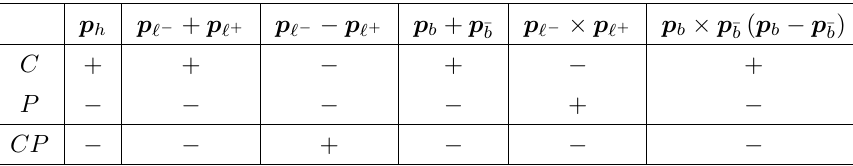
Table 1 . Momenta with well-de(cid:12)ned C and P eigenvalues. The b; (cid:22) b; ‘ + and ‘ (cid:0) are the top decay products. The last column is a rank-2 tensor | a direct product of an axial and a polar